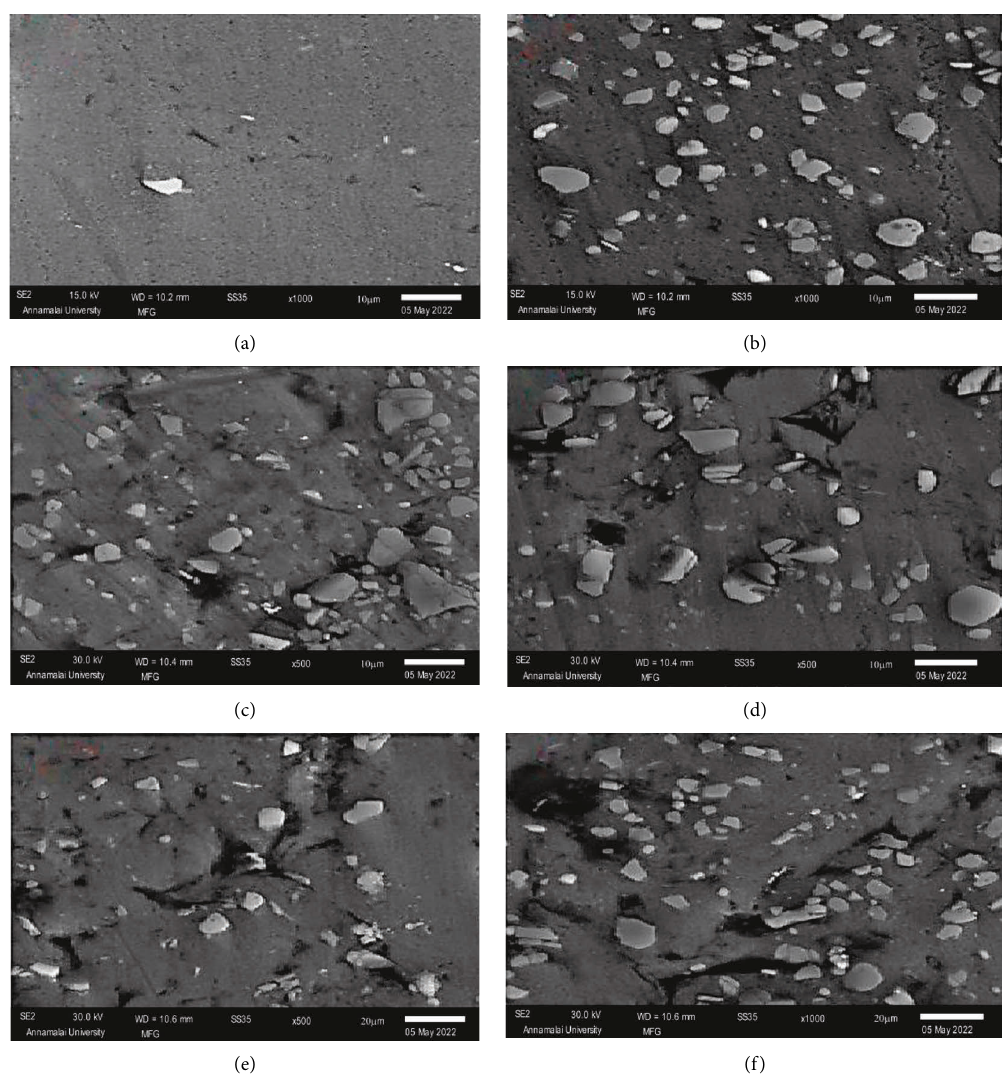
Figure 2: SEM images of (a) Al 6061, (b) Al 6061+10% B 4 C, (c) Al 6061+10% B 4 C +1% CNT, (d) Al 6061+10% B 4 C +1.5% CNT, (e) Al 6061+10% B 4 C + 2% CNT, and (f) Al 6061+10% B 4 C +2.5% CNT.